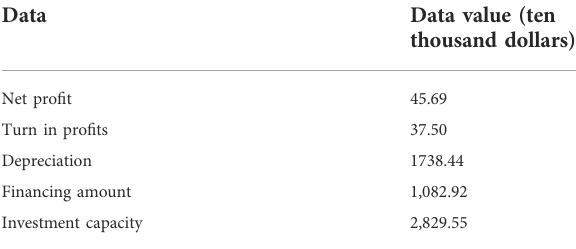
TABLE 6 Calculation results of power grid investment capacity.